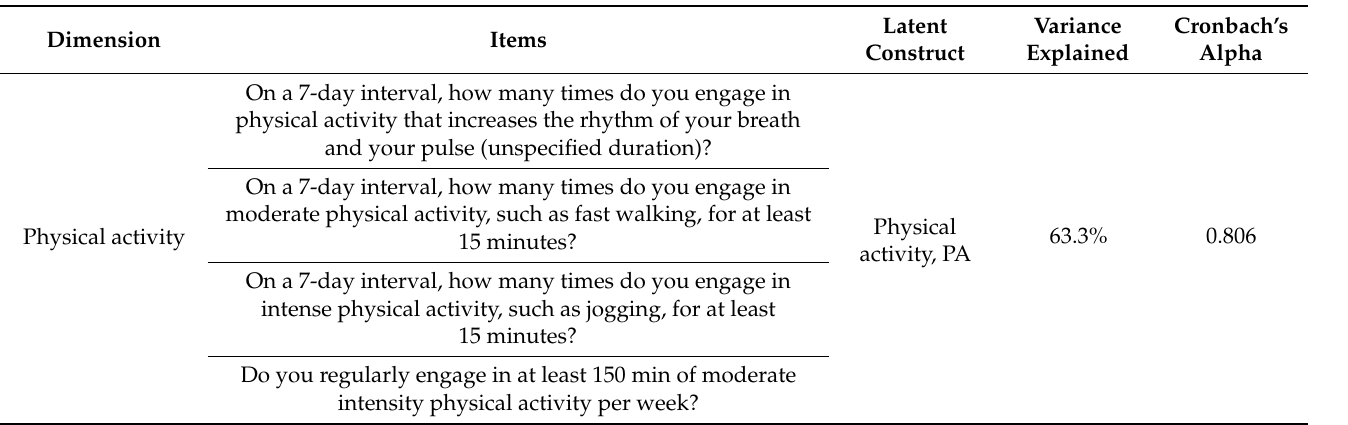
Table 1. Measurement items by YPAP